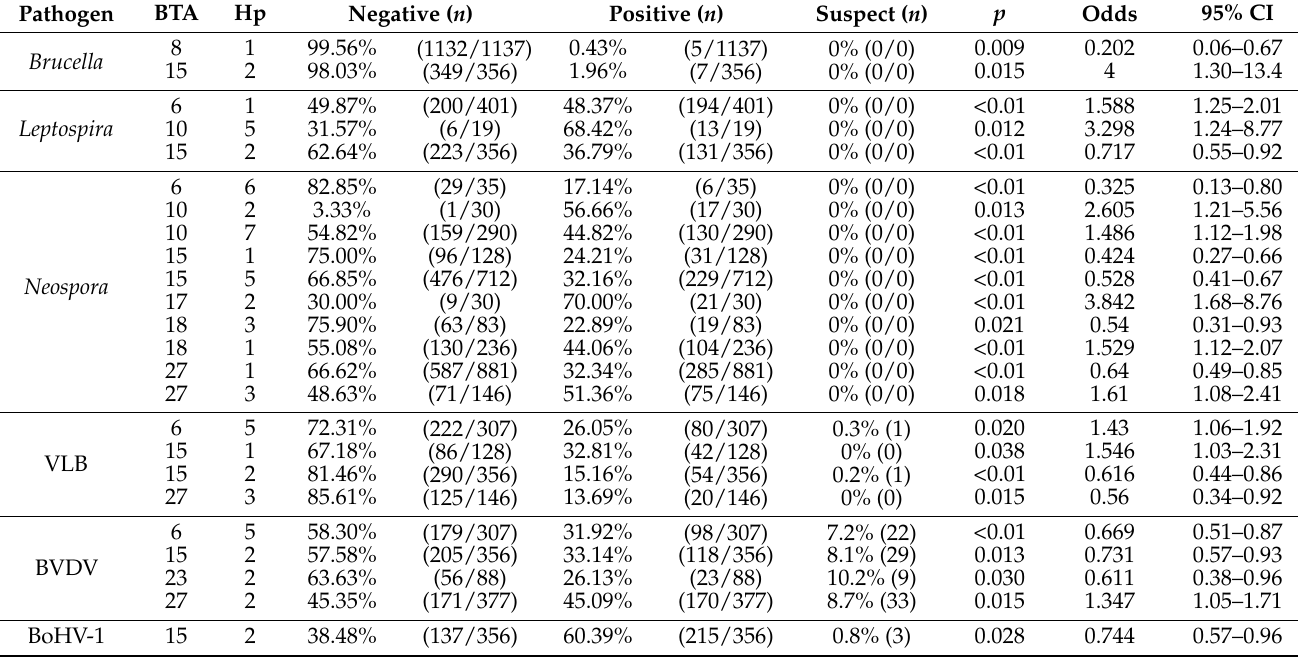
Table 6. Final model of logistic regression of SNP haplotypes and infectious diseases in Curraleiro P é -Duro cattle.